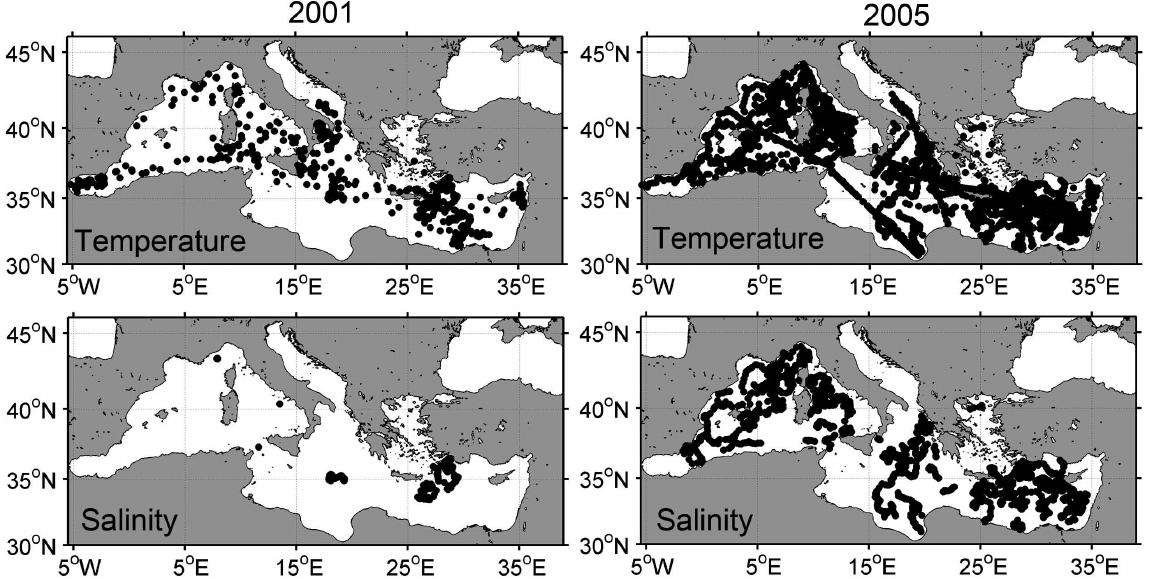
f ig . 2. – Spatial distribution of T (top row) and S (bottom row) profiles with data at or below 300 m for the years 2001 (left column) and 2005 (right column).